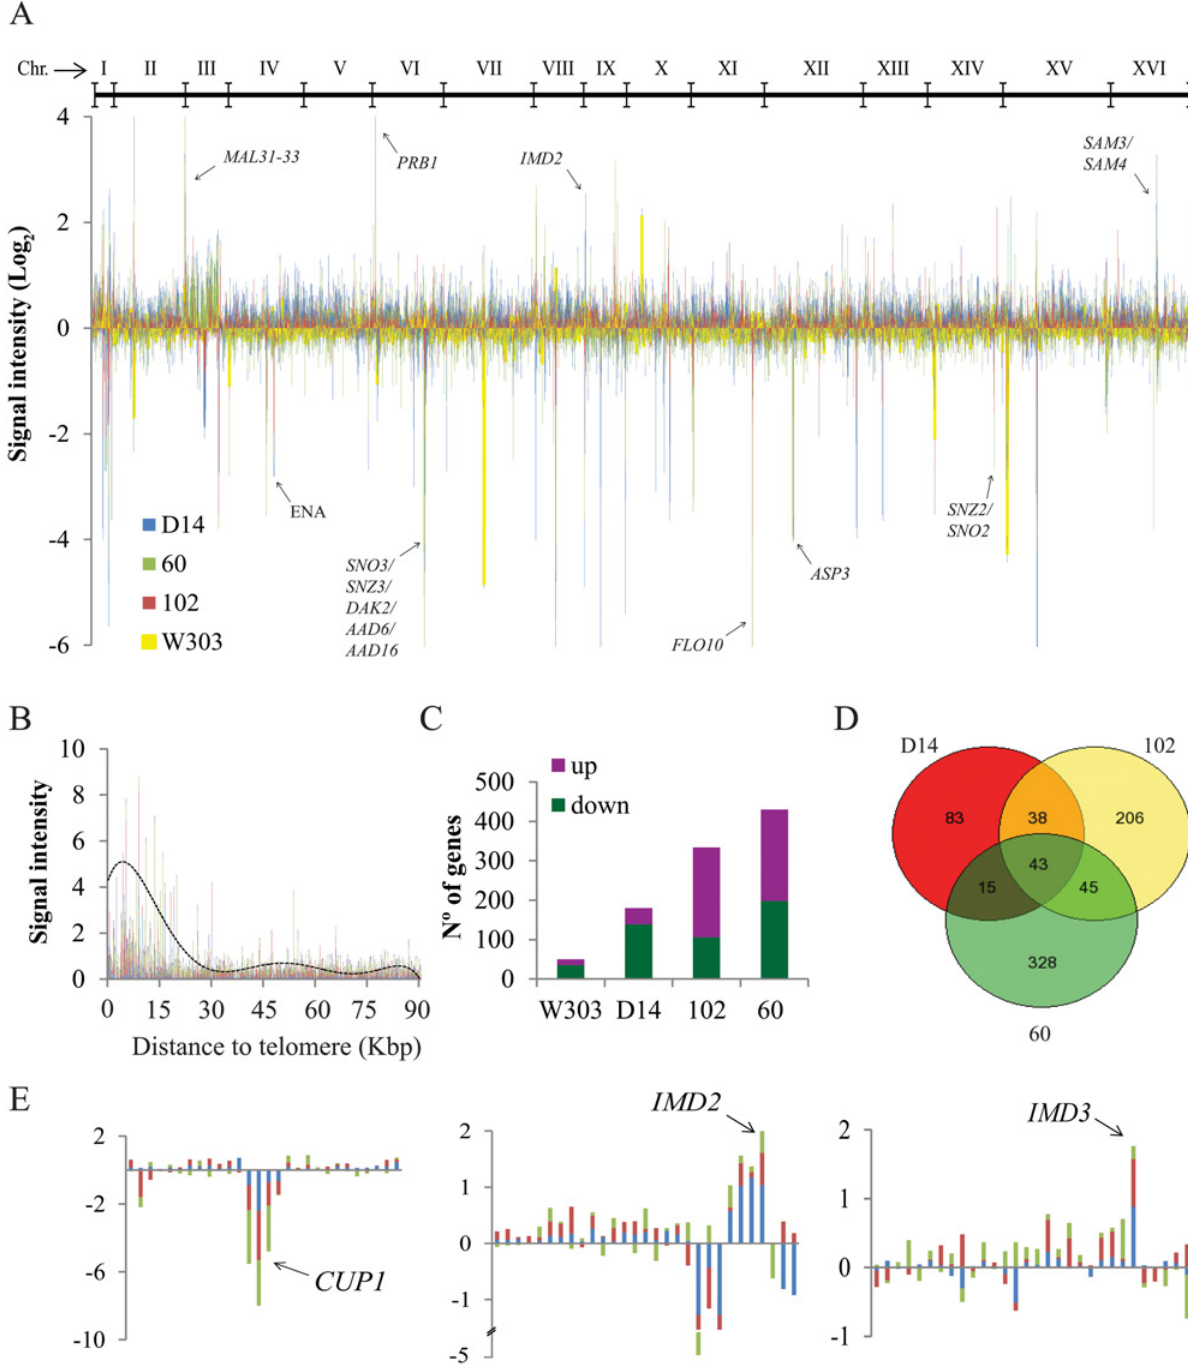
Fig 1. Comparative genomic hybrization of opportunistic strains. D14, 60 and 102 were compared to laboratory strain W303 hybridizing DNA to S288C cDNA microarray. A) Log2 of normalized and filtered data of the four strains is represented according its chromosomal disposition in stack bar graph. Specific genes are depicted with an arrow. B) Absolute signal intensity of genes is represented against distance to telomere. Discontinuous line represents sliding window average (10x) of values in 1 Kbp. C) Number of genes in increased or decreased CNV represented for each strain. D) Venn diagram showing the number of specific or common genes for strains D14, 103 and 60. E) Local zoom of general graph presented in A) for genes IMD3 , IMD2 and CUP1 chromosomal regions for opportunistic strains.